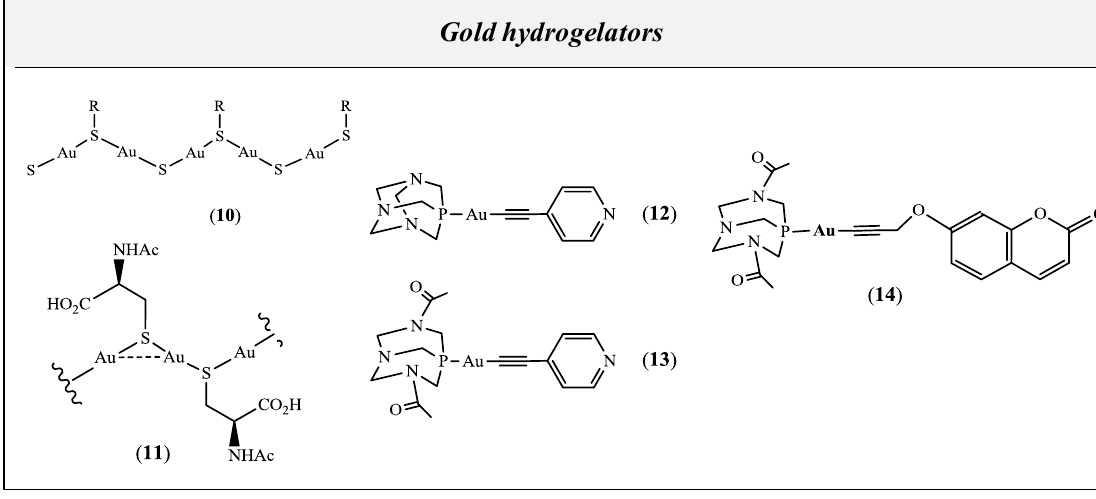
Figure 8. Gold hydrogelators reported in the